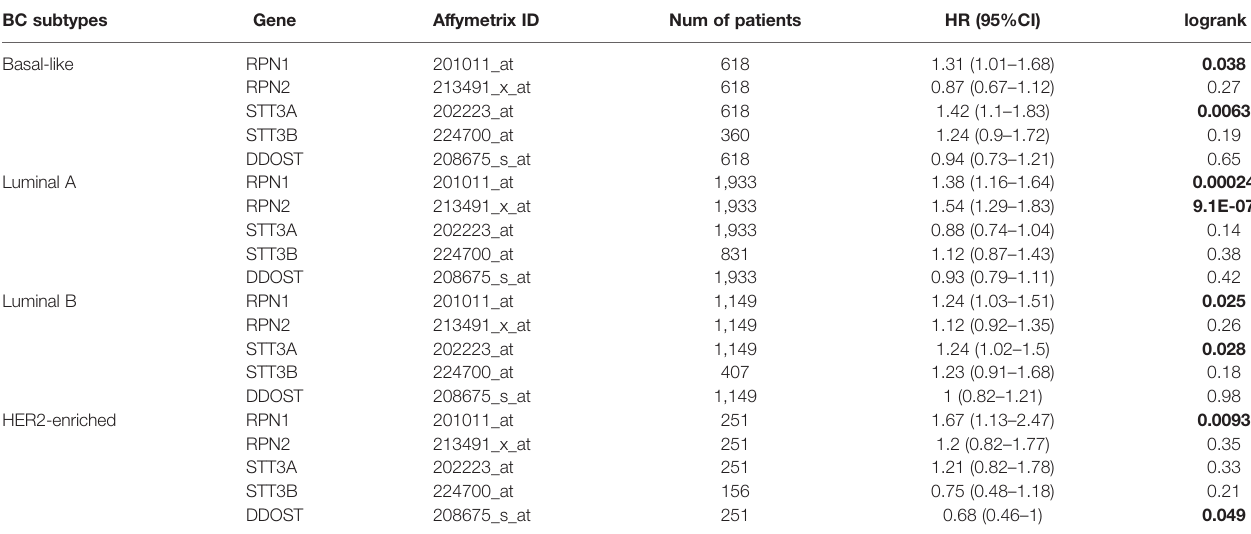
TABLE 2 | RFS of the RPN1, RPN2, STT3A, STT3B, and DDOST with different molecular subtypes in breast